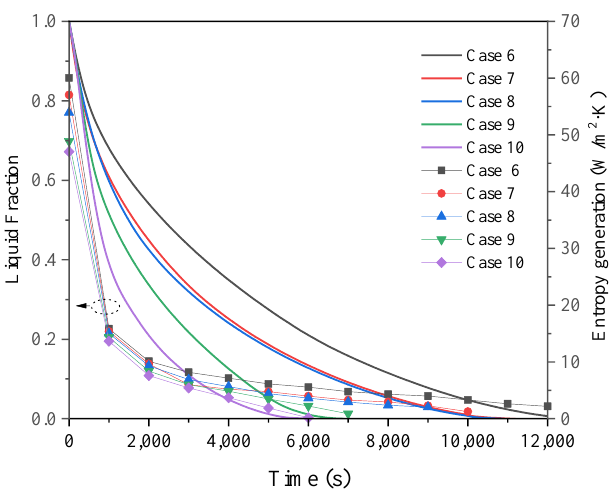
Figure 16. Liquid fractions and global entropy generation for Cases